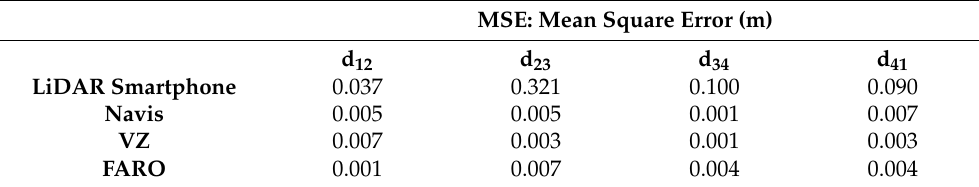
Table 5. Root mean square error of distance data d12, d23, d34d, and d41 from VZ, Navis, and FARO sensors.